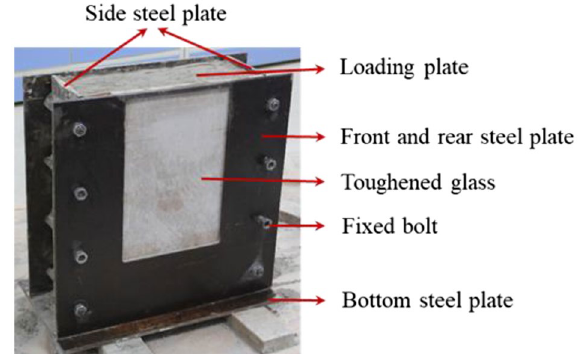
Figure 3. Testing model.